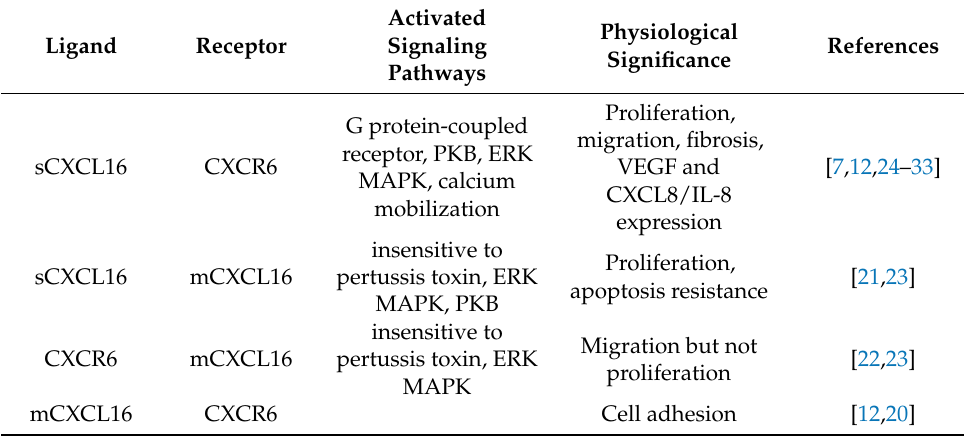
Table 1. Activities of the two different forms of